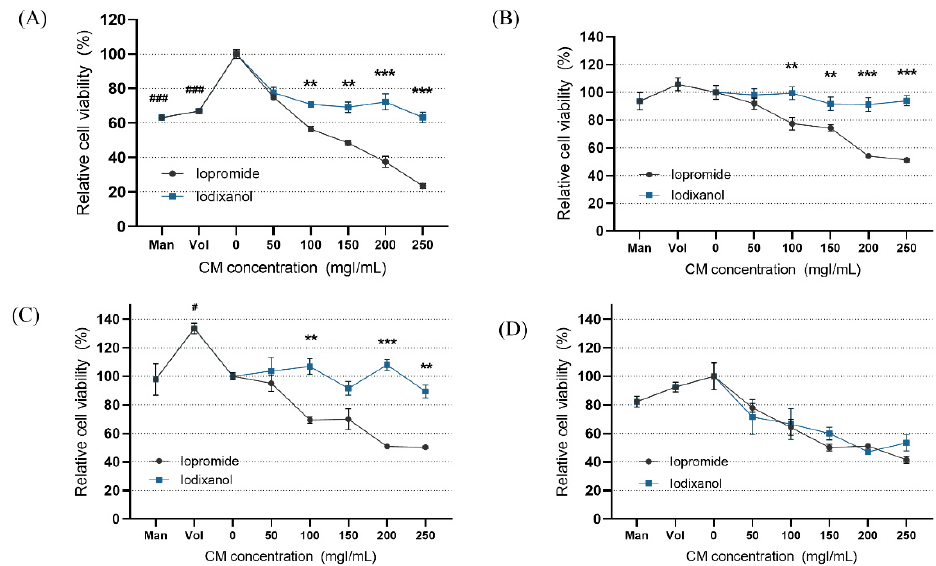
Figure 4. Cell viability according to the different fluid viscosity and shear ‐ stress conditions at ( A ) static condition, ( B ) a rocker interval of 8 min, ( C ) a rocker interval of 4 min, and ( D ) a rocker interval of 2 min. CM—contrast media; Man—mannitol; HES—hydroxyethyl starch; Con—negative control group. Data are represented as the mean ± SEM. ### p < 0.001 versus control (0 mgI/mL); # p < 0.05 versus control (0 mgI/mL); ** p < 0.01 versus iopromide group of the same iodine concentration; *** p < 0.001 versus iopromide group of the same iodine concentration.